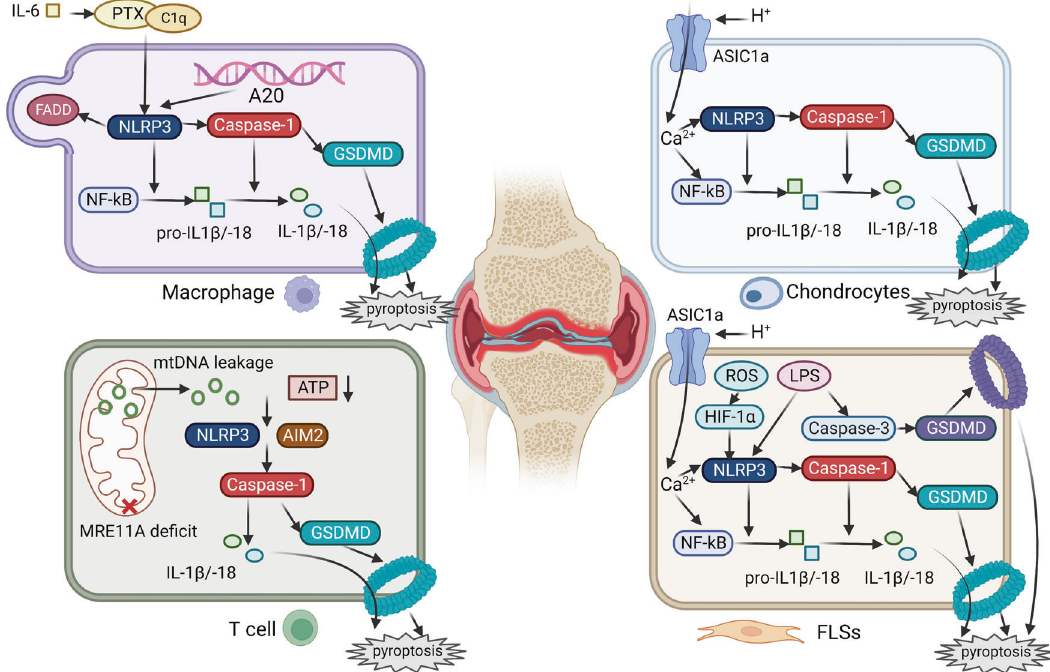
Fig. 4 Pyroptosis in RA pathogenesis. RA is characterized by synovitis and cartilage degeneration. Autoimmune components and immune cells are involved in RA. In synovial tissue in fi ltrating macrophages, NLRP3 is activated by PTX3 and C1q, which is enhanced by IL-6 and regulated by A20. A de fi cit of mitochondrial gene MRE11A in T cells leads to mtDNA instability and leakage, decreased cytosolic ATP, and activation of NLRP3 and AIM2 in fl ammasomes, which participate in canonical jointly. Decreased H + in RA synovial fl uid promotes the opening of ASIC1a ion channels on chondrocytes and synovial cells, leading to Ca 2 + in fl ux and activation of NLRP3. In FLSs, the classical pyroptosis pathway is mainly activated by ROS and LPS. LPS also leads to GSDMD cleavage and non-classical pore formation through caspase-3